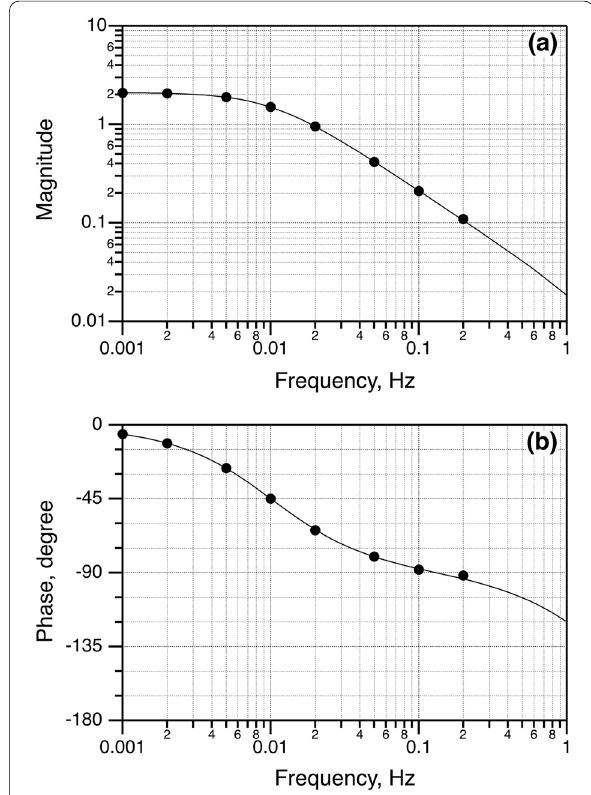
Fig. 6 Transfer function (the right-hand side of Eq. (38)) of the SG CT #036 as a function of frequency, measured by the signal injection experiment. Dots are the measured values. Curves are theoretically calculated using the estimated parameters. a Magnitude. b